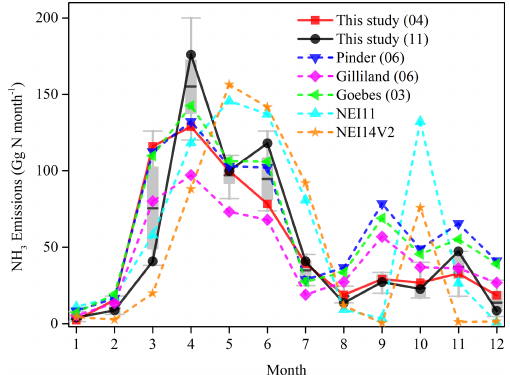
Figure 9. Comparison of monthly NH 3 emission patterns between our estimate and other studies. Two typical monthly patterns of NH 3 emission in this study were used. The estimate of 2004 repre- sents the pattern when planting date is early, whereas the simulation of 2011 stands for the pattern when planting date is delayed. Two simulations using different approaches by EPA NEI were chosen in the comparison. Grey boxes include 25%–75% of monthly NH 3 emissions during 2005–2015 estimated by this study, black lines are mean values, and whiskers comprise the whole range of